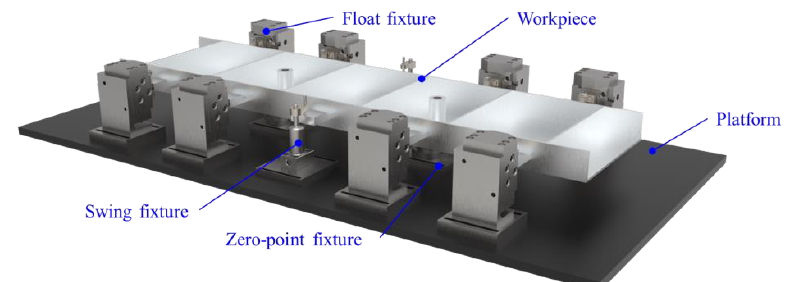
Figure 9. Floating clamping system.